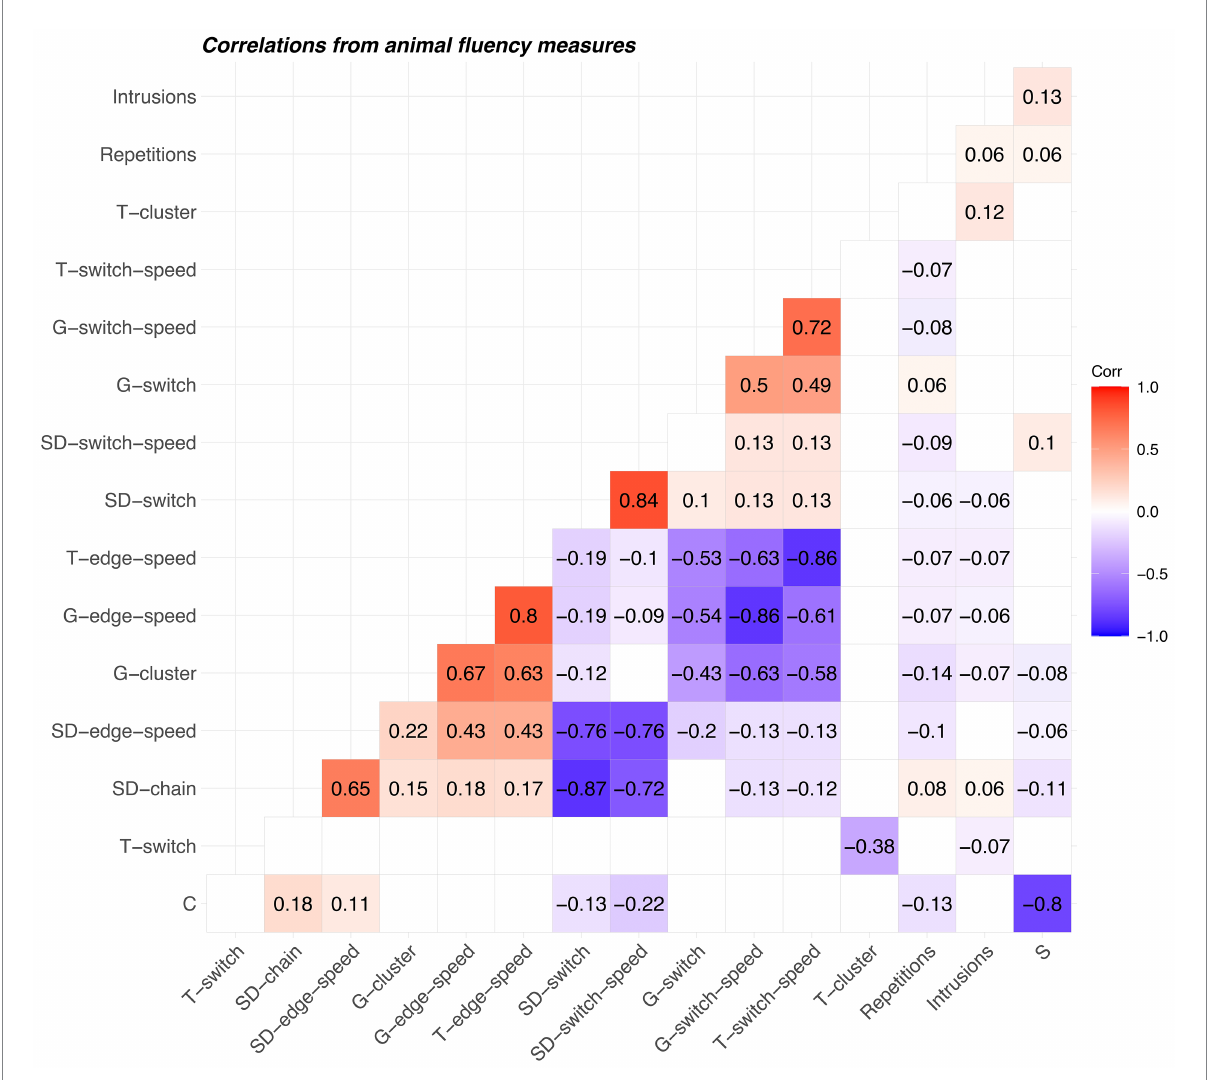
FIGURE 6 Correlation matrix of scores derived from animal fluency. Prior to calculating the correlations, the raw scores were regressed out of all scores tabulated here. T, Troyer method; G, graph-theoretic (network) method; SD, slope difference algorithm; C, Mayr constant term; S, Mayr slope term. SD “chain” scores are comparable to cluster scores, but are based only on linkages between consecutive